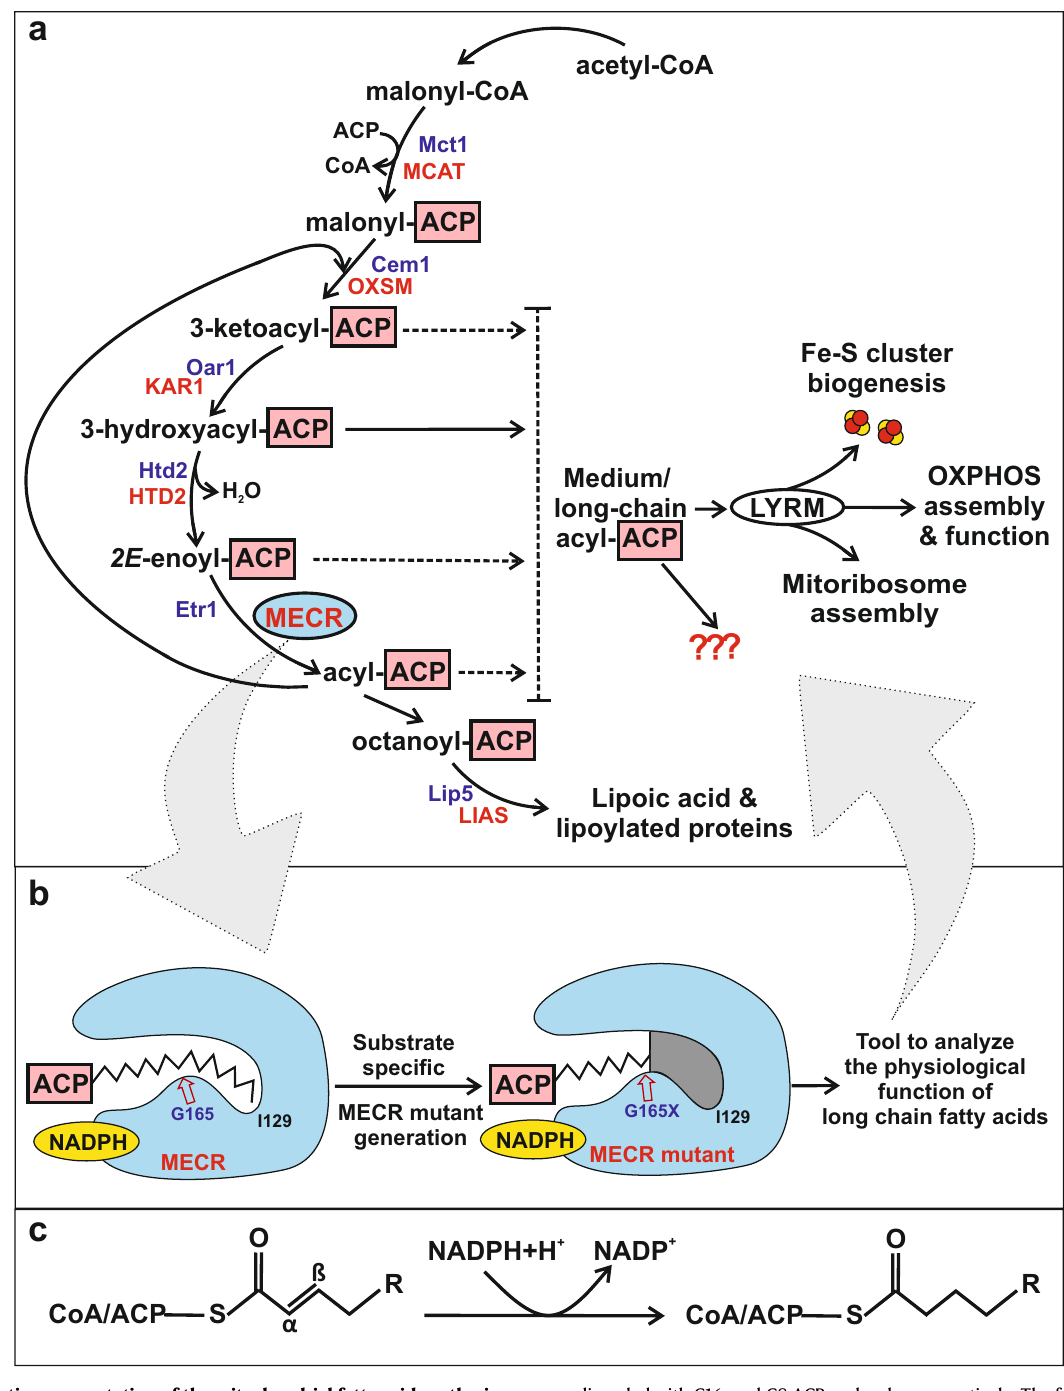
Fig. 1 | Schematic representation of the mitochondrial fatty acid synthesis (mtFAS) pathway, wild-type and engineered MECR and the reaction catalyzed by MECR/Etr1. a Schematic depiction of the mtFAS pathway. The indicated abbreviations (yeast (blue) /human (red)): Mct1/MCAT malonyl-CoA transferase, ACPacylcarrierprotein,Cem1/OXSM3-ketoacyl-ACPsynthase,Oar1/KAR1ketoacyl reductase, Htd2/HTD2 3-hydroxyacyl-thioester dehydratase, Etr1/MECR enoyl- thioesterreductase,Lip5/LIASlipoicacidsynthetase. b Schematicrepresentationof